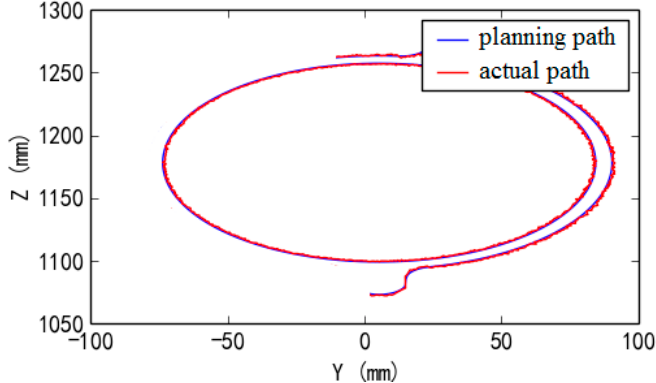
Figure 30. Experimental deburring results of target planning path and actual tool path of distal side facet.